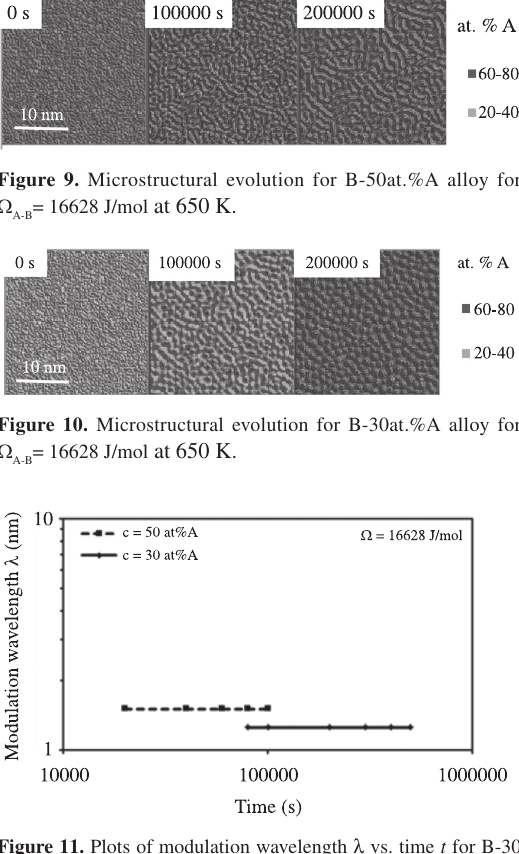
Figure 11. Plots of modulation wavelength λ vs. time t for B-30 and 50at.%A alloys for Ω = 16628 J/mol at 650 K. A-B